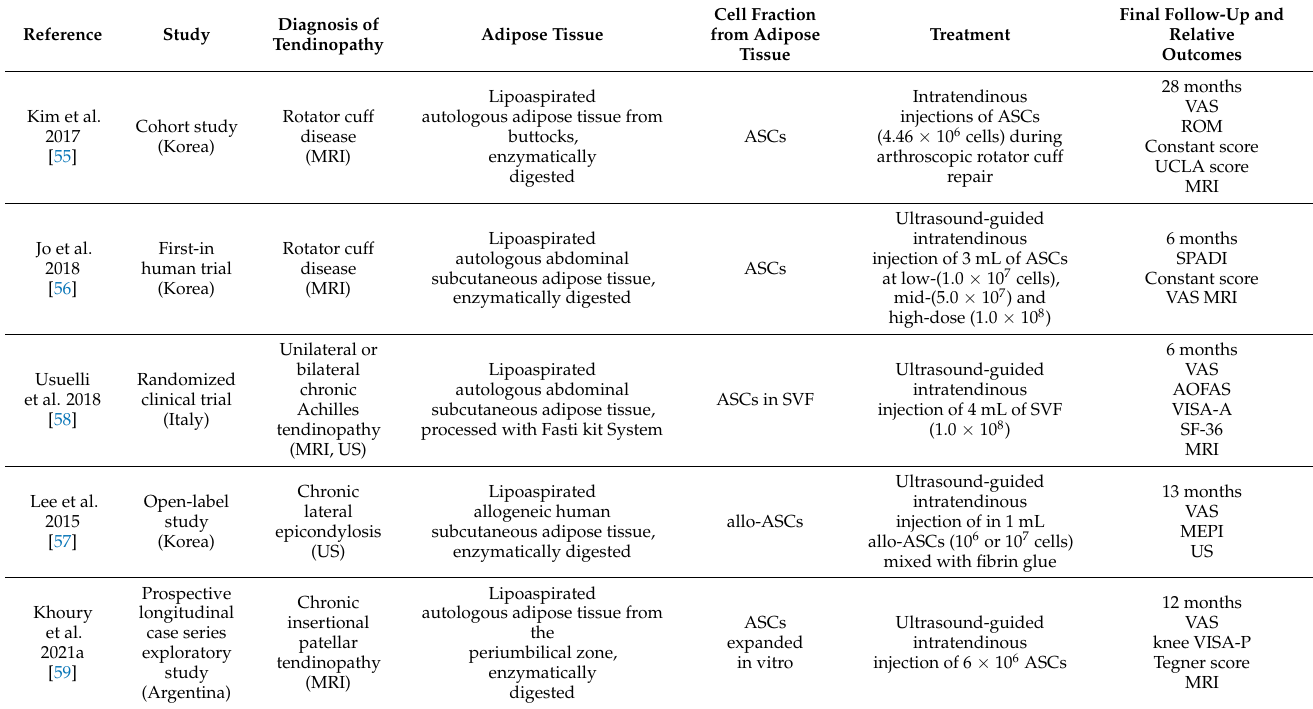
Table 1. Study design and methodology of the included